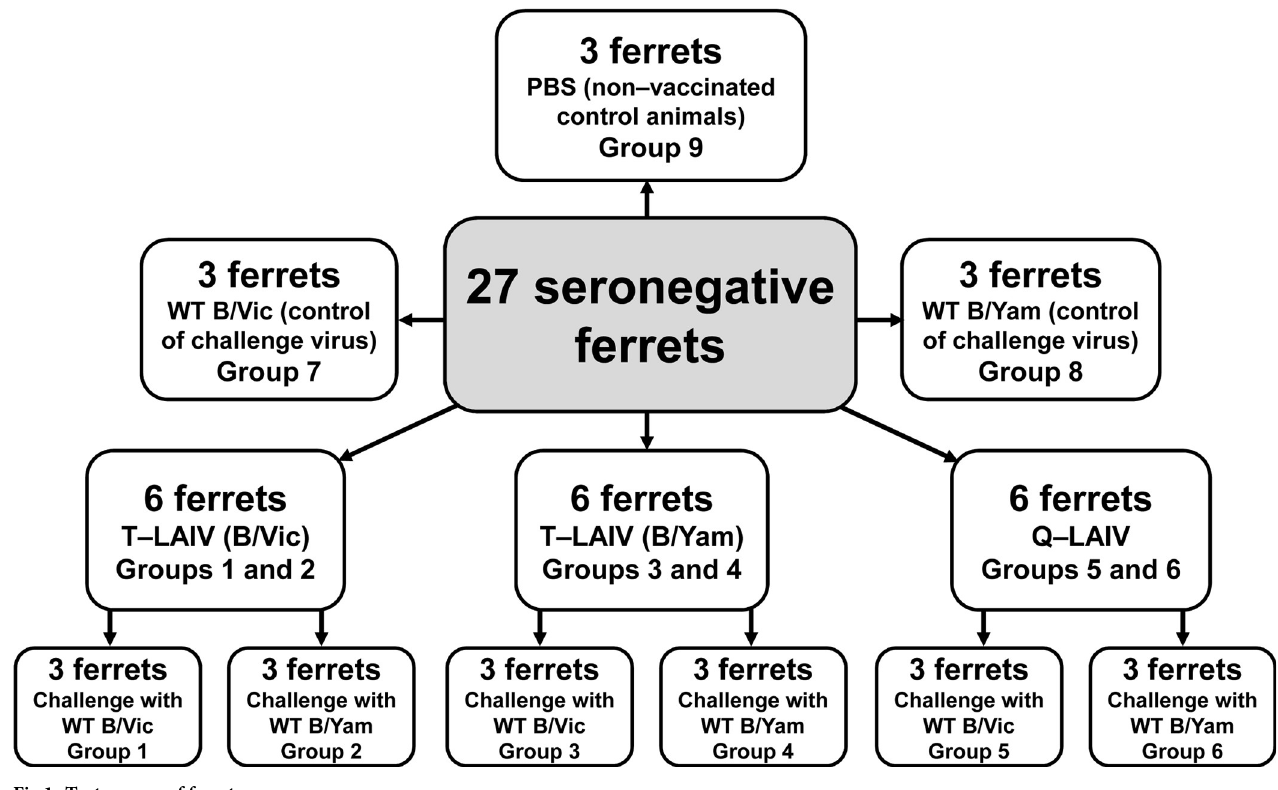
Fig 1. Test groups of